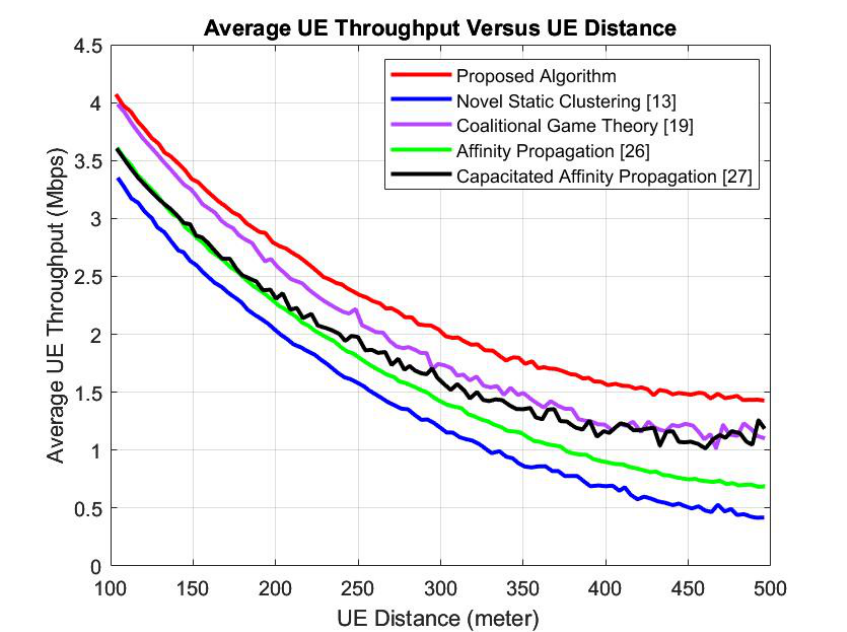
Figure 4. Average UE throughput versus the UE distance.